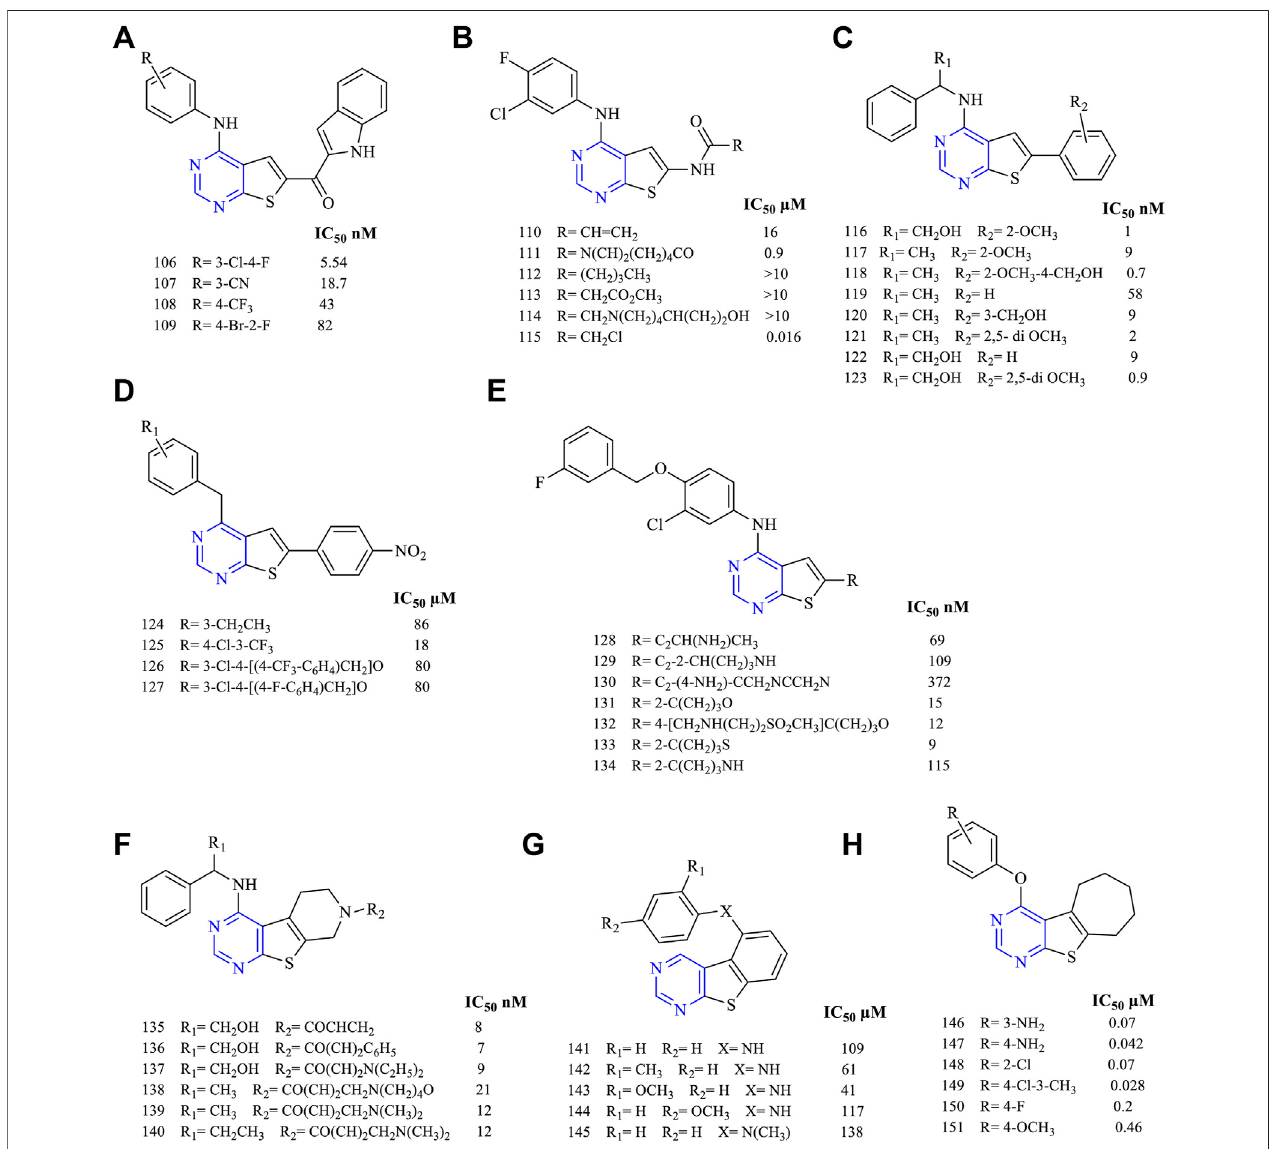
FIGURE 12 | Chemical structure of (A) 4-substituted anilinothieno[2,3- d ]pyrimidine-6-methanone, (B) 4-substituted anilinothieno[2,3- d ]pyrimidin-6-amide, (C) 4- substituted amino-6-phenylthieno[2,3- d ]pyrimidine, (D) 4-anilino-6-phenylthieno[2,3- d ]pyrimidine, (E) substituted phenyl thieno[2,3- d ]pyrimidine, (F) fused pyridine thieno[2,3- d ]pyrimidine, (G) fused substituted phenyl thieno[2,3- d ]pyrimidine, and (H) fused cycloheptane thieno[2,3- d ]pyrimidine.